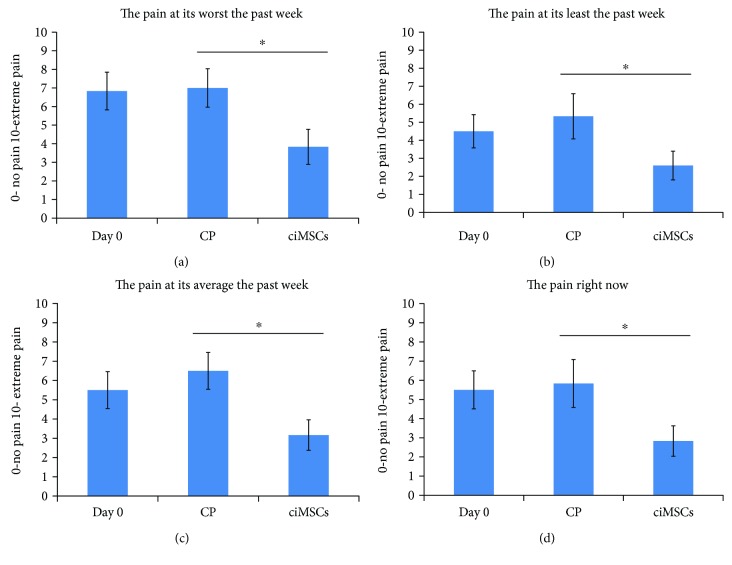
Mean scores (±standard error of the mean) of the questions on pain of the canine brief pain inventory at baseline (day 0), after placebo control product (CP) administration (week 6) and after xenogeneic chondrogenic induced mesenchymal stem cell (ciMSC) administration (week 12). The asterisk (∗) indicates a significant difference in mean scores between the two treatment groups (P < 0.05).